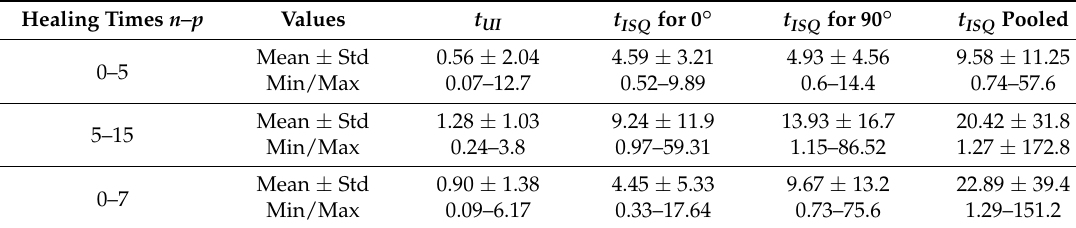
Table 4. Comparison of the error realized on the estimation of the healing time using the quantitative ultrasound (QUS) and RFA measurements in both directions (0 ◦ and 90 ◦ ) and for both directions pooled. The mean and standard deviation values are shown as well as the maximum and minimum values for all implants and each time